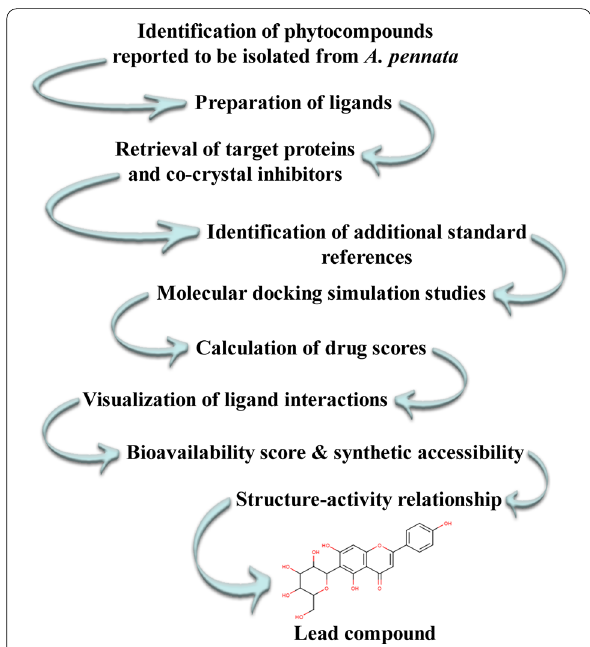
Fig. 2 Research methodology of the present